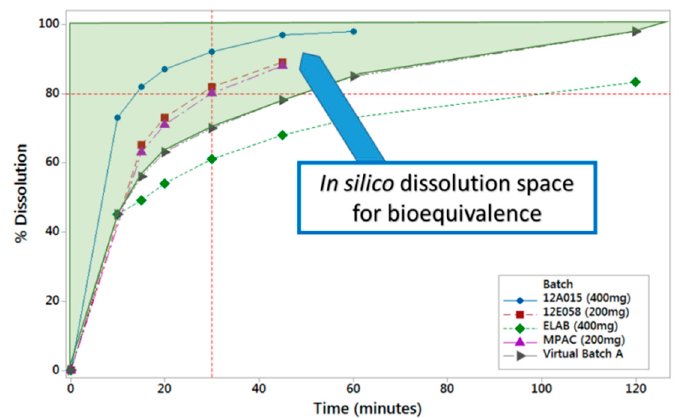
Figure 3. In vitro dissolution space where lesinurad products are predicted to be bioequivalent based on in silico absorption modelling.